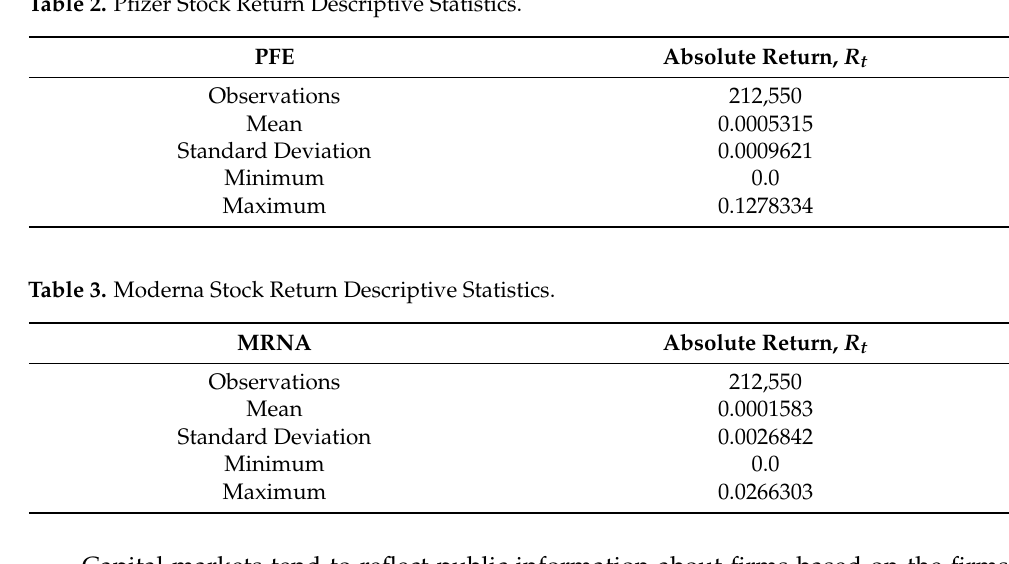
Table 2. Pfizer Stock Return Descriptive Statistics.